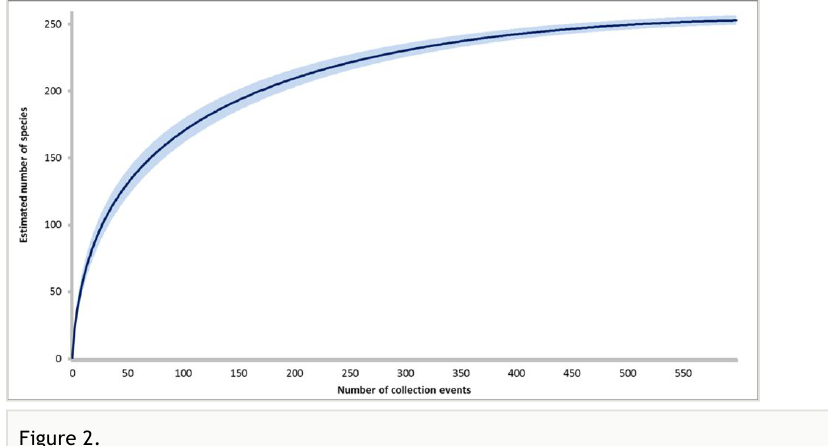
Figure 2. Species accumulation curve generated for bee species sampled in 558 collection events between 2013 and 2015. Species estimates were generated using EstimateS. The blue line represents the mean species accumulation, and the light blue shaded area represents the upper and lower bound of 95% con fi dence interval for species